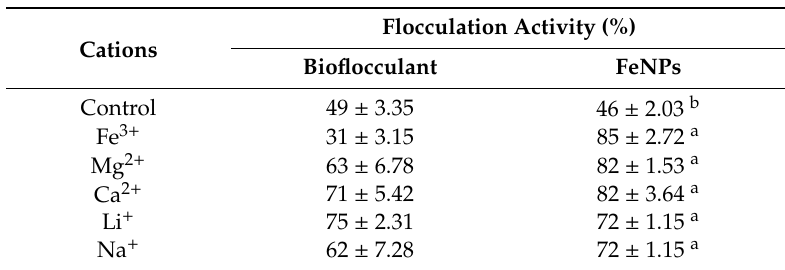
Table 2. Cation e ff ect on flocculation Table 2. Cation effect on flocculation activity.